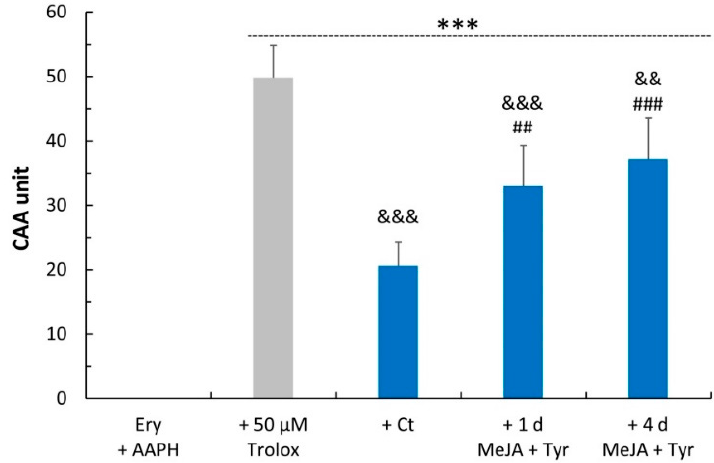
Figure 6. Cellular antioxidant activity (CAA) of hemp cell extracts evaluated in an ex vivo human erythrocyte system. Trolox was used as a reference standard. Values represent the mean ± SD of five measurements. Ery + AAPH: erythrocytes exposed to AAPH; Ct: control; 1 d: 1 day; 4 d: 4 days; MeJA: methyl jasmonate; Tyr: tyrosine. One-way ANOVA with Bonferroni’s post hoc test was applied: * indicates significance versus Ery + AAPH (*** p ≤ 0.001); # indicates significance versus the Ct sample ( ## p ≤ 0.01; ### p ≤ 0.001); and & indicates significance versus 50 µ M Trolox ( && p ≤ 0.01; &&& p ≤ 0.001).